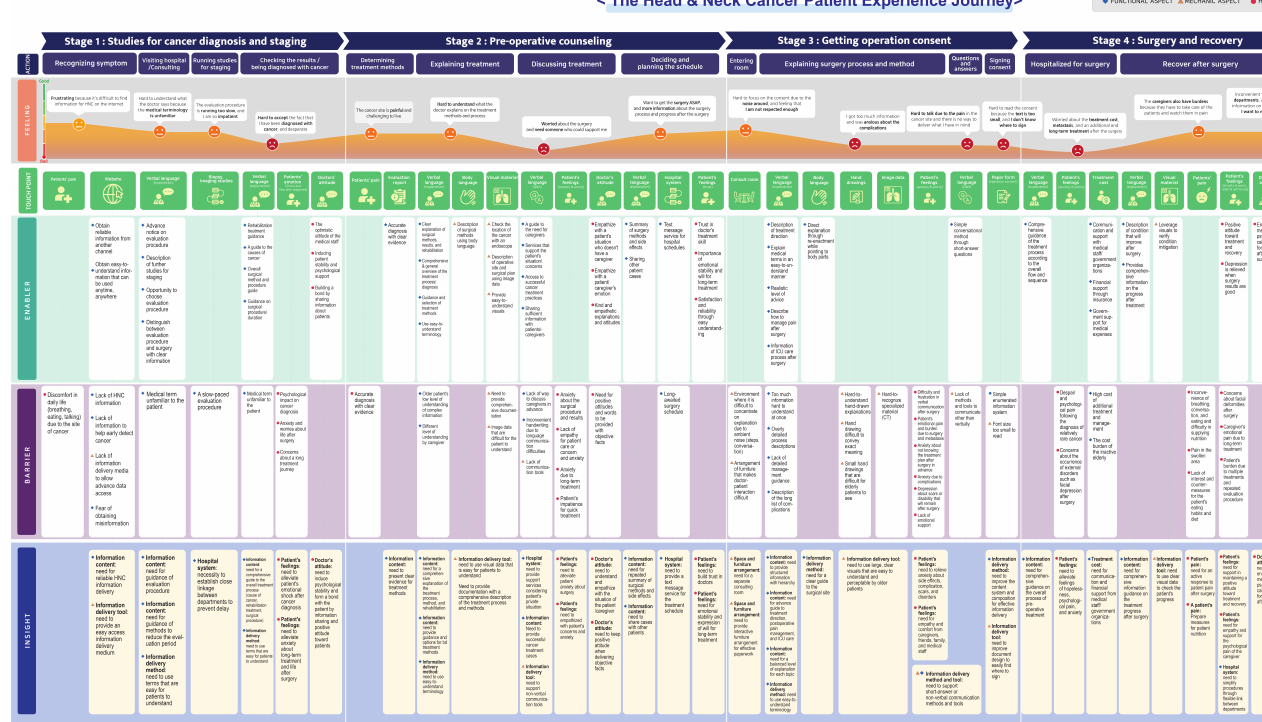
Figure 2. The integrated patient journey map consists of five